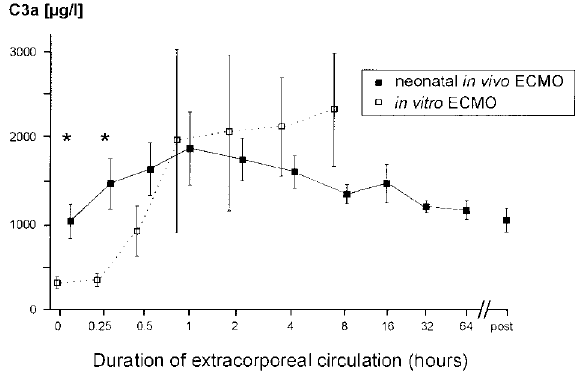
FIG. 1. C3a concentration (mean ± SEM) in in vivo neonatal ECMO and in in vitro ECMO ( n = 6 for both groups). At 0h and 0.25h, C3a is different in neonatal and in vitro ECMO (* p < 0.05 by Mann–Whitney U test). Both groups show sig- nificant changes with time during the observation period (Friedman variance analysis). Post, 12h after decanulation.